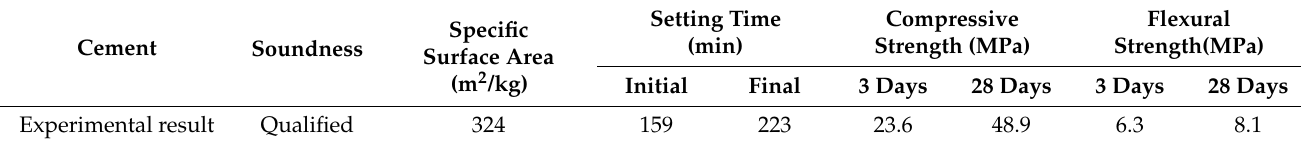
Table 1. Physical and mechanical properties of cement.